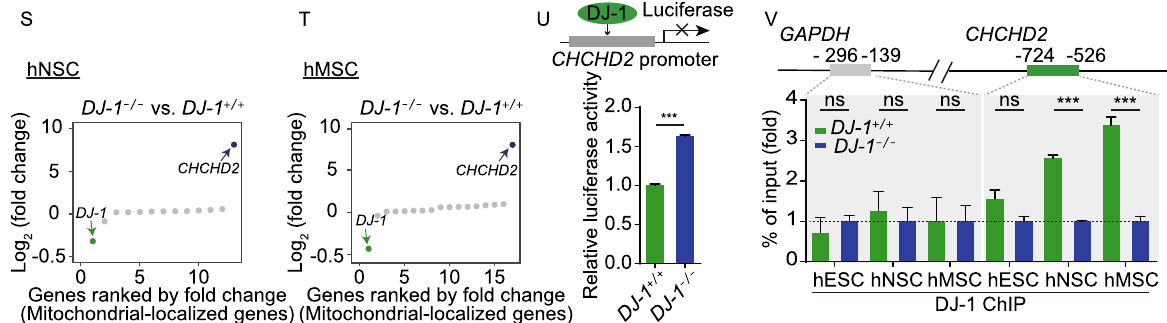
Figure 2. DJ-1-de fi cient hMSCs and hVECs maintained cellular homeostasis . (A) Immuno fl uorescence analysis of DJ-1 expression in WT and DJ-1 − / − hMSCs. Scale bar, 10 µm. (B) Immuno fl uorescence analysis of Ki67 expression in WT and DJ-1 − / − hMSCs. Left, images of immunostaining for the Ki67 at P8 (LP, late passage). Right, quanti fi cation of Ki67-positive cells in WT and DJ-1 − / − hMSCs at P4 (EP, early passage) and P8 (LP). Scale bar, 25 µm. Data are presented as the mean ± SEM, n = 3. ns, not signi fi cant. (C) SA- β -gal staining of WT and DJ-1 − / − hMSCs. Left, images of SA- β -gal staining at P9 (LP, late passage). Right, quanti fi cation of SA- β -gal-positive cells in WTand DJ-1 − / − hMSCs at P4 (EP) and P9 (LP). Scale bar, 50 μ m. Data are presented as the mean ± SEM, n = 3. ns, not signi fi cant. (D) Immuno fl uorescence analysis of 53BP1 and γ H2AX expression in WT and DJ-1 − / − hMSCs. Data are presented as the mean ± SEM, n = 3. ns, not signi fi cant. Scale bar, 25 μ m. (E) Immuno fl uorescence analysis of 4-HNE expression in WT and DJ-1 − / − hMSCs. Data are shown as the mean ± SEM, n = 3. ns, not signi fi cant. Scale bar, 25 µm. (F) Cellular total ROS levels were determined by staining with the CM-H 2 DCFDA probe and analyzed by FACS. Data are presented as the mean ± SEM, n = 3. ns, not signi fi cant. (G) Mitochondrial mass levels were determined by staining with NAO probe and measured by FACS. Data are presented as the mean ± SEM, n = 3. ns, not signi fi cant. (H) Analysis of luciferase activity in the TA muscles of immunode fi cient mice by an in vivo imaging system (IVIS). WT (1 × 10 6 , left) and DJ-1 − / − (1 × 10 6 , right) hMSCs (passage 6) transduced with luciferase were implanted into the muscles of mice. Luciferase activities were imaged and quanti fi ed at days 0, 1, 3, and 5 after implantation. Data are presented as the mean ± SEM, n = 4. ns, not signi fi cant. (I) Immuno fl uorescence analysis of DJ-1 expression in WTand DJ-1 − / − hVECs. Scale bar, 10 μ m. (J) Phase-contrast images of hVECs to the left. Scale bar, 50 µm. Immuno fl uorescence staining of hVEC-speci fi c markers, VE-cadherin and CD31 to the right. Scale bar, 25 μ m. (K) Immuno fl uorescence staining of Dil-Ac-LDL in WT and DJ-1 − / − hVECs. Scale bar, 25 µm. (L) Flow cytometry analysis of l nitric oxide (NO) levels in WT and DJ-1 − / − hVECs. Data are presented as the mean ± SEM, n = 3. ns, not signi fi cant. (M) Flow e cytometry analysis of total ROS levels in WTand DJ-1 − / − hVECs. Data are presented as the mean ± SEM, n = 3. ns, not signi fi cant. (N) Transcriptional signals of DJ-1 in WT and DJ-1 − / − hNSCs and hMSCs. Data were normalized by RPKM at bin size of 10 bp. (O) Heatmap illustrating FPKM normalized expression level of each gene in WTand DJ-1 − / − hNSCs. (P) Heatmap illustrating FPKM normalized expression level of each gene in WT and DJ-1 − / − hMSCs. (Q) Immuno fl uorescence staining of CHCHD2 in WT and DJ-1 − / − hNSCs (left) and hMSCs (right). Scale bar, 10 µm. (R) Western blotting analysis of CHCHD2 and DJ-1 expression in hNSCs (left), and hMSCs (right). β -actin was used as the loading control. (S) Scatter plot showing the fold change of mitochondrial-localized genes (adjusted P ≤ 0.05) in DJ-1 − / − hNSCs compared to WT hNSCs. (T) Scatter plot showing the fold change of mitochondrial- localized genes (adjusted P ≤ 0.05) in DJ-1 − / − hMSCs compared to WT hMSCs. (U) Transcriptional activity of CHCHD2 in WT and DJ-1 − / − hMSCs measured by dual luciferase reporter assay. WT and DJ-1 − / − hMSCs were co-transfected with pGL3- CHCHD2 promoter and Renilla plasmids. Data are presented as the mean ± SEM, n = 3. *** P < 0.001. (V) ChIP-qPCR assessment of the enrichment of DJ-1 at the CHCHD2 promoter in hESCs, hNSCs and hMSCs. Data are presented as the mean ± SEM, n = 4. *** P < 0.001, ns, not signi fi cant. Notably, we observed minimal global changes in the gene expression pro fi le of DJ-1 − / − hNSCs and hMSCs compared with those of WT hNSCs and hMSCs, respectively (Fig. 2O and 2P). While DJ-1 has been reported to regulate the transcription of NRF2 and its target genes (Biosa et al., 2017), we did not detect any marked change in the expression levels of NRF2 target genes between WT and DJ-1 − / − hNSCs and hMSCs (Fig. S3G and S3H). Only 12